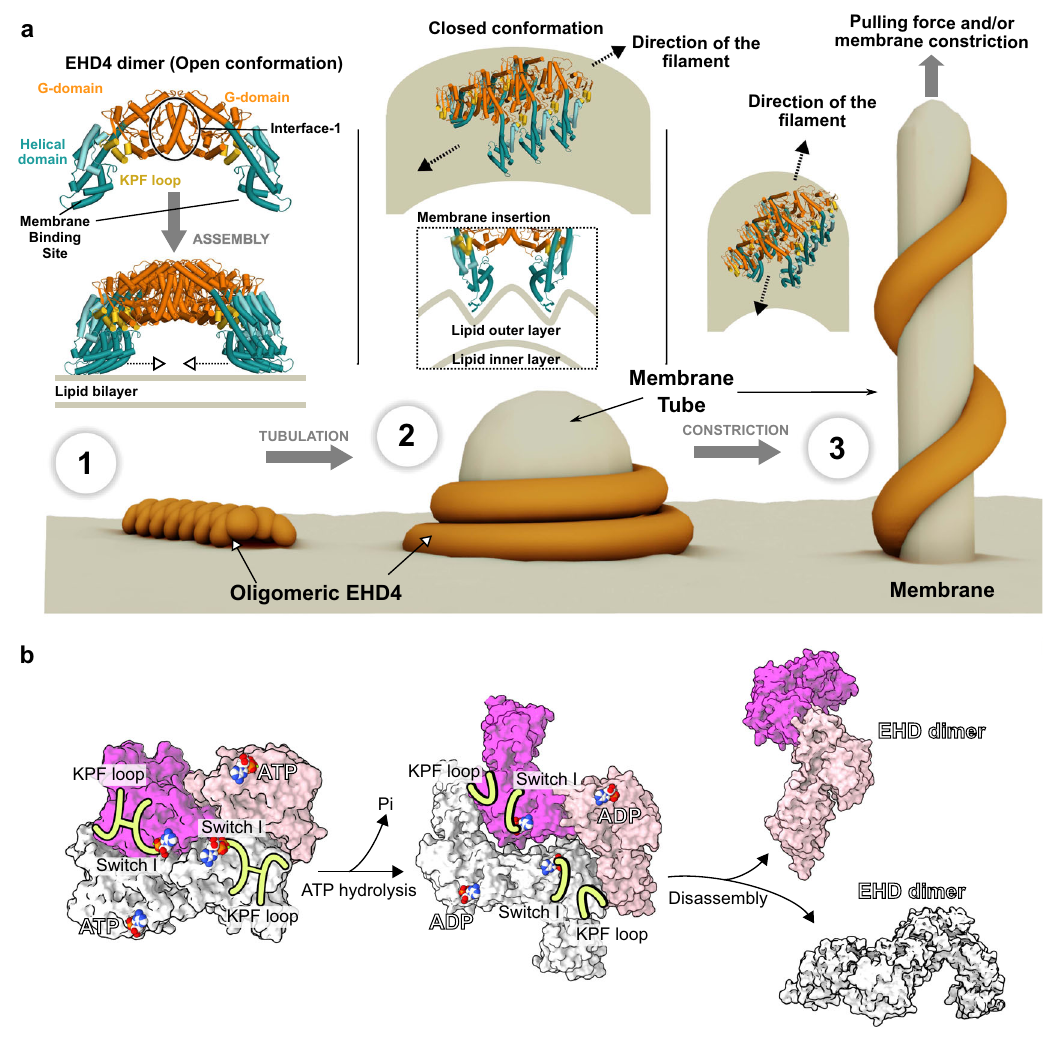
Fig. 6 | Model for EHD-mediated membrane remodeling. a 1) ATP-bound EHD dimers are recruited to fl at membranes in the open conformation where they oli- gomerize via interface-2 into fi laments of low curvature. 2) Membrane curvature induces the transition of the open to closedconformation. In turn, insertionof the membrane-binding site into the membrane promotes membrane curvature, which